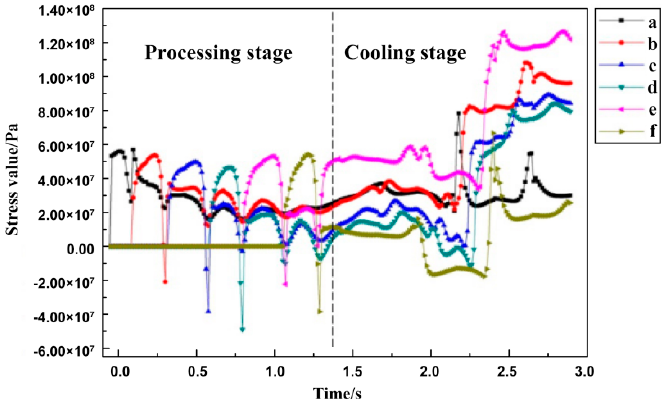
Figure 9. The variation of residual stress σ x with time at the midpoint of each scan line.